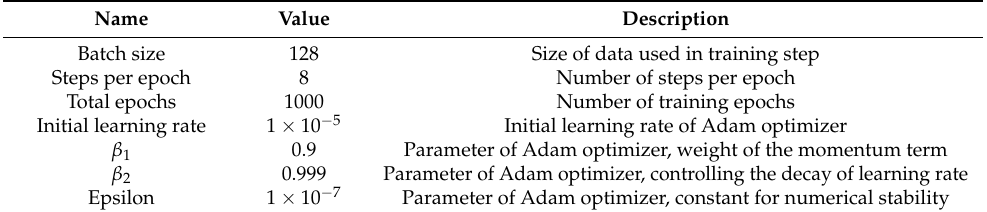
Table 4. Training case of random excitation.